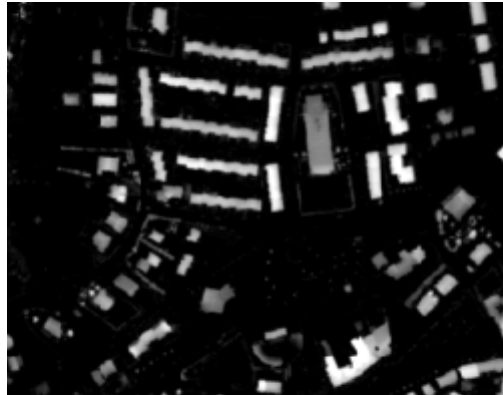
Figure 4. The normalized Digital Surface Model (nDSM) smoothed.